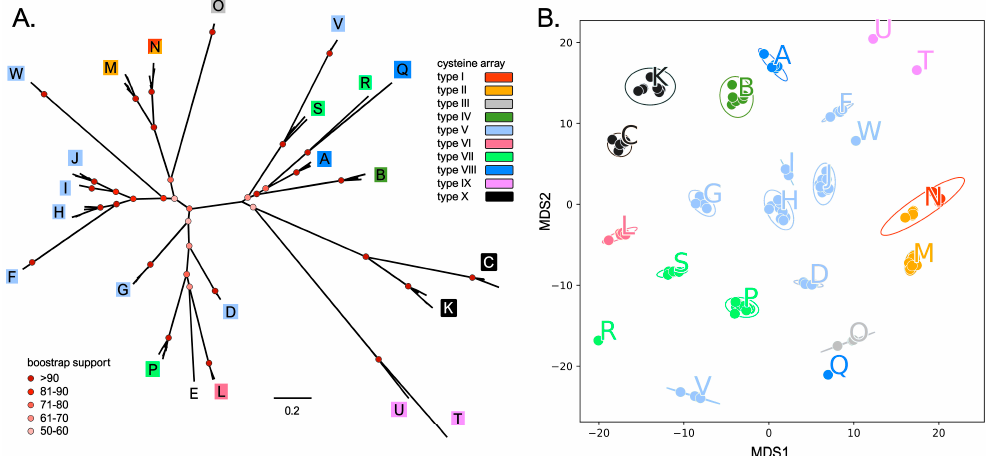
Figure 2. Panel ( A ): maximum likelihood unrooted phylogenetic tree of mussel sCRP-I sequences. Each of the 23 groups is indicated with a letter, and the background color refers to one of the ten types of cysteine arrays (see Figure 1B). For simplicity’s sake, only the bootstrap support values of the major nodes of the tree are displayed with colored circles. Panel ( B ): MDS plot obtained from the pairwise Hamming distances between the sCRP-I sequences reported in this study. Each dot marks a sequence and each group of sequences is colored based on the type of characterizing disulfide array (see Figure 1B).